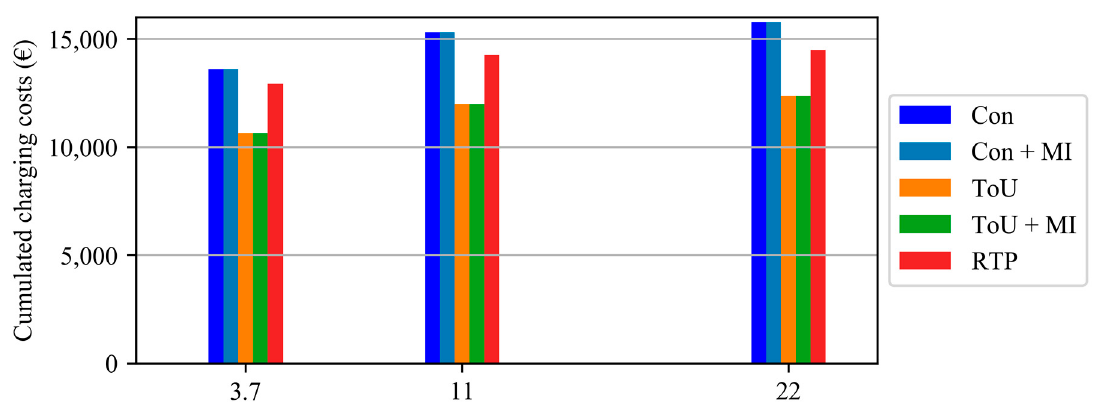
Figure 9. Cumulated charging costs in € for five operating strategies and three maximum charging power levels. For this analysis, the 11,103 vehicle availabilities of the GER MP field trial were used.